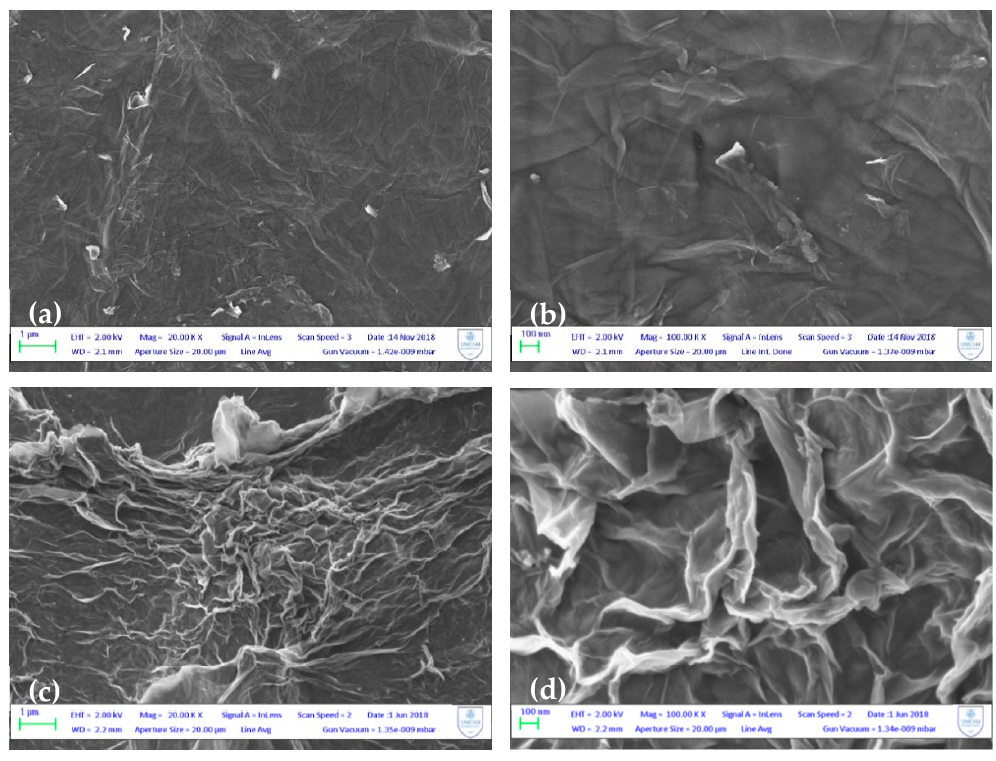
Figure 5. SEM images with different magnifications of GO ( a , b ) and rGO ( c , d ) sheets.